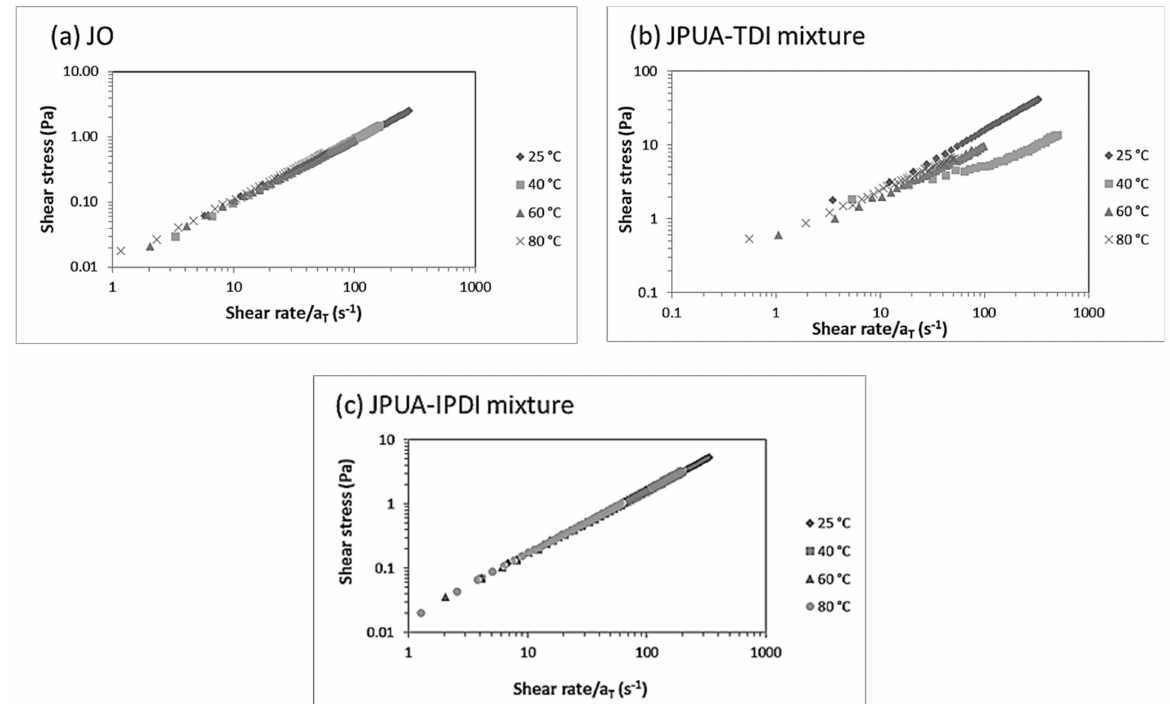
Figure 7. Shear rate-based master curve graphs of ( a ) JO, ( b ) JPUA-TDI and ( c ) JPUA-IPDI at 25 ◦ C, 40 ◦ C, 60 ◦ C and 80 ◦